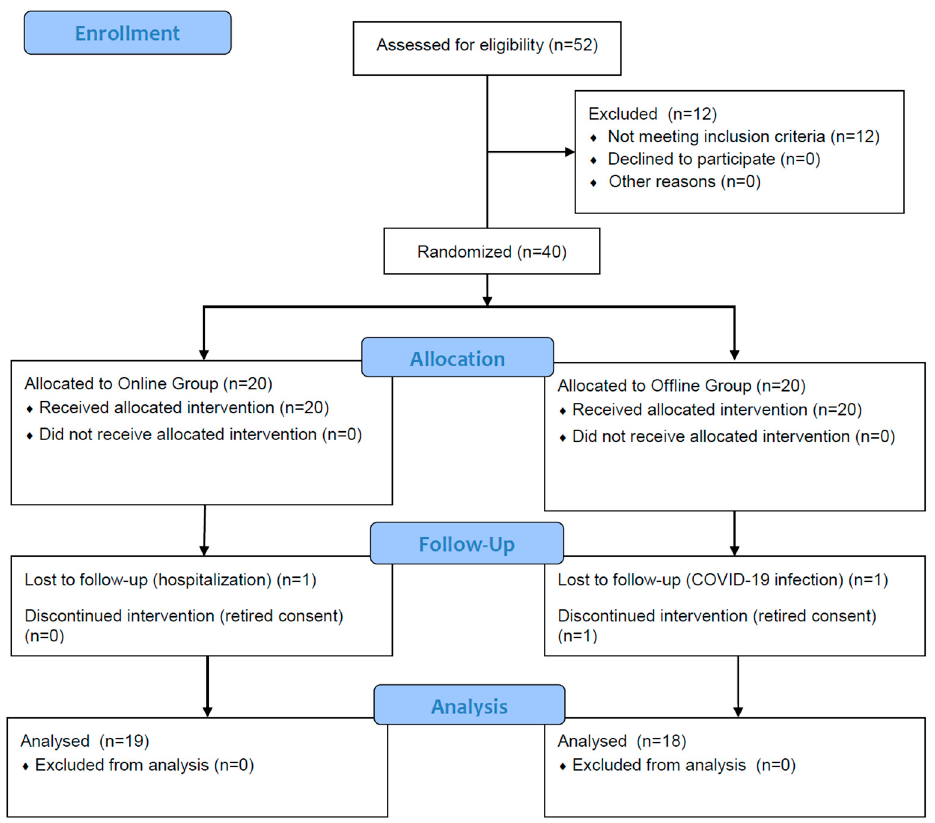
Figure 1. A flowchart of the study .